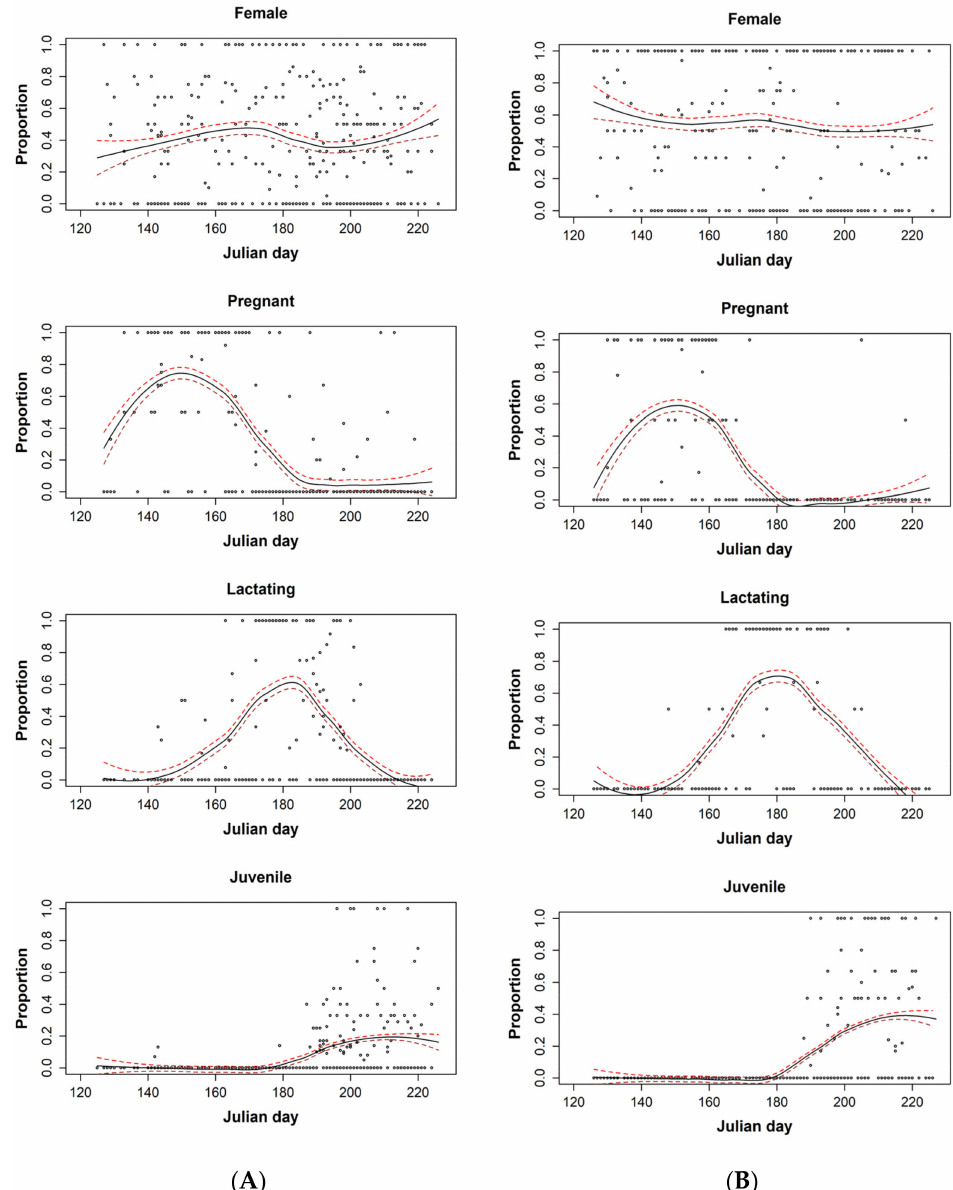
Figure 2. The samples (circles) and locally estimated scatterplot smoothing lines for the proportion of juvenile, pregnant, and lactating ( A ) big brown bats ( Eptesicus fuscus ; EPFU) and ( B ) eastern red bats ( Lasiurus borealis ; LABO). Mist-net sampling was conducted within the mid-Atlantic region between 2015 and 2018. Circles reflect each sample where the proportion of lactating female or juvenile bats was